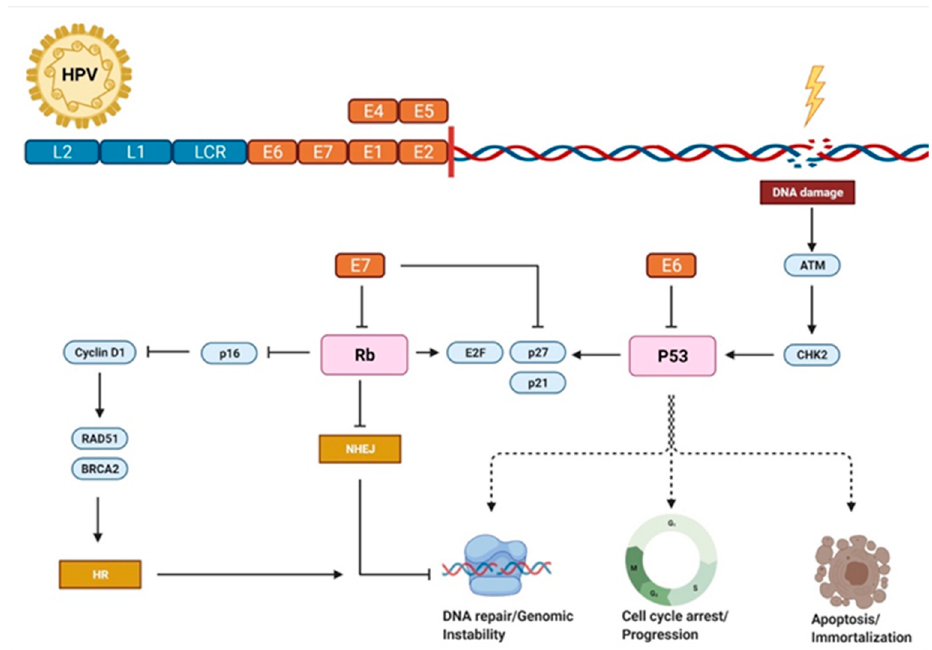
Figure 2. E6 and E7 increase radiosensitivity of HPV-positive cervical cancer cells. An increased sensitivity to radiation by HPV-positive malignancies has been linked to several signaling pathways, including regulation of cell cycle progression, apoptosis and chromosomal instability. Shown is a simplified illustration of DNA damage repair signaling pathways impaired by altered TP53 and p16 activity. After the downregulation of retinoblastoma protein (Rb) by viral oncoprotein E7, increasing p16 levels hamper homologous recombination (HR) regulated via cyclin D1 and subsequently the RAD51/BRCA2 axis. Rb loss further diminishes the non-homologous end-joining (NHEJ) repair pathway. Cell cycle progression and G1-S transition are promoted by the release of the transcription factor E2F and the inhibition of cyclin-dependent kinase (CDK) inhibitors p21 and p27, while in contrast frequently triggered G2/M arrest reorders and arrests cancer cells at vulnerable stages of the cell cycle. Abbreviations: ATM: ataxia telangiectasia mutated; CHK2: checkpoint kinase 2; HPV: human papilloma virus. Adapted from “P53 Regulation and Signaling”, by BioRender.com (accessed on 5 September 2021). Retrieved from https://app.biorender.com/biorender-templates (accessed on October